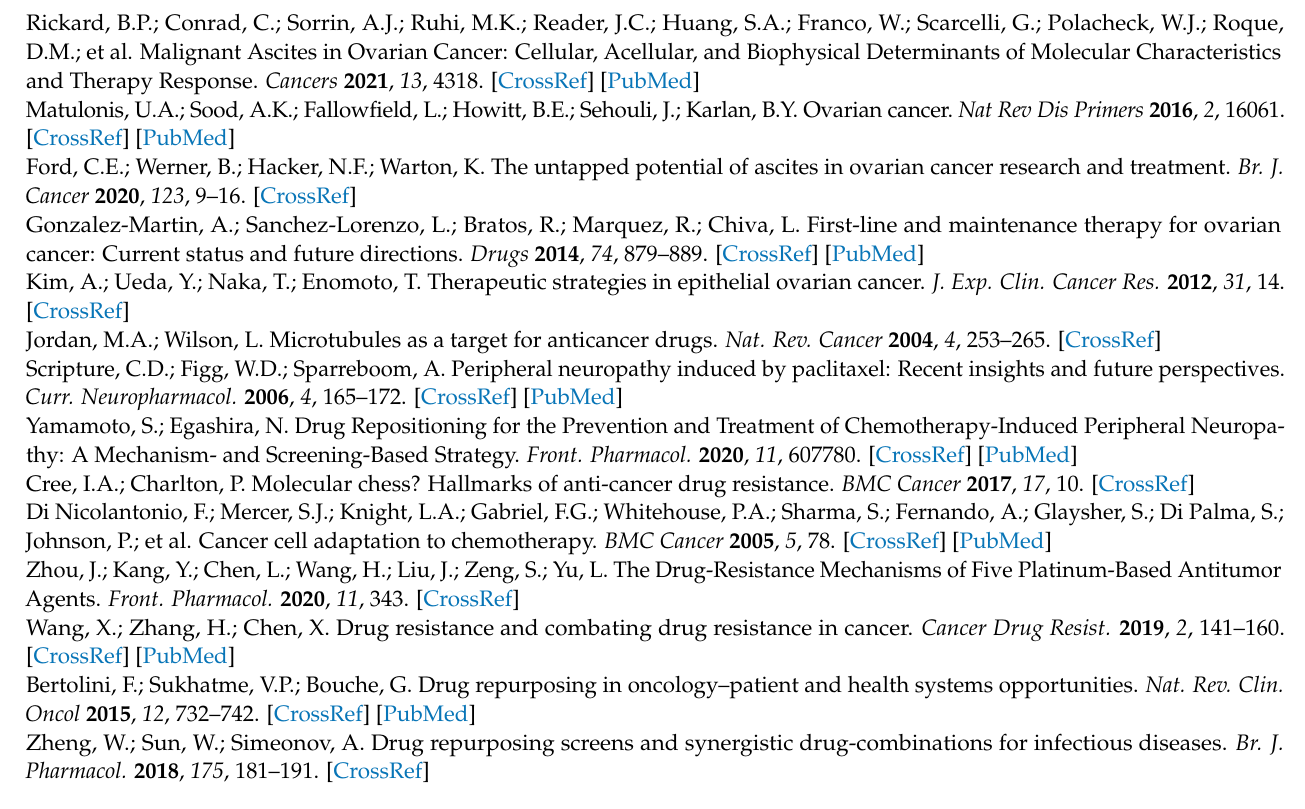
Table S2. Fractional effect (Fa) values and respective combinatory index (CI) values showing drug synergism of HOSE6.3 cells. Table S3. Cellular viability (%) of HOSE6.3